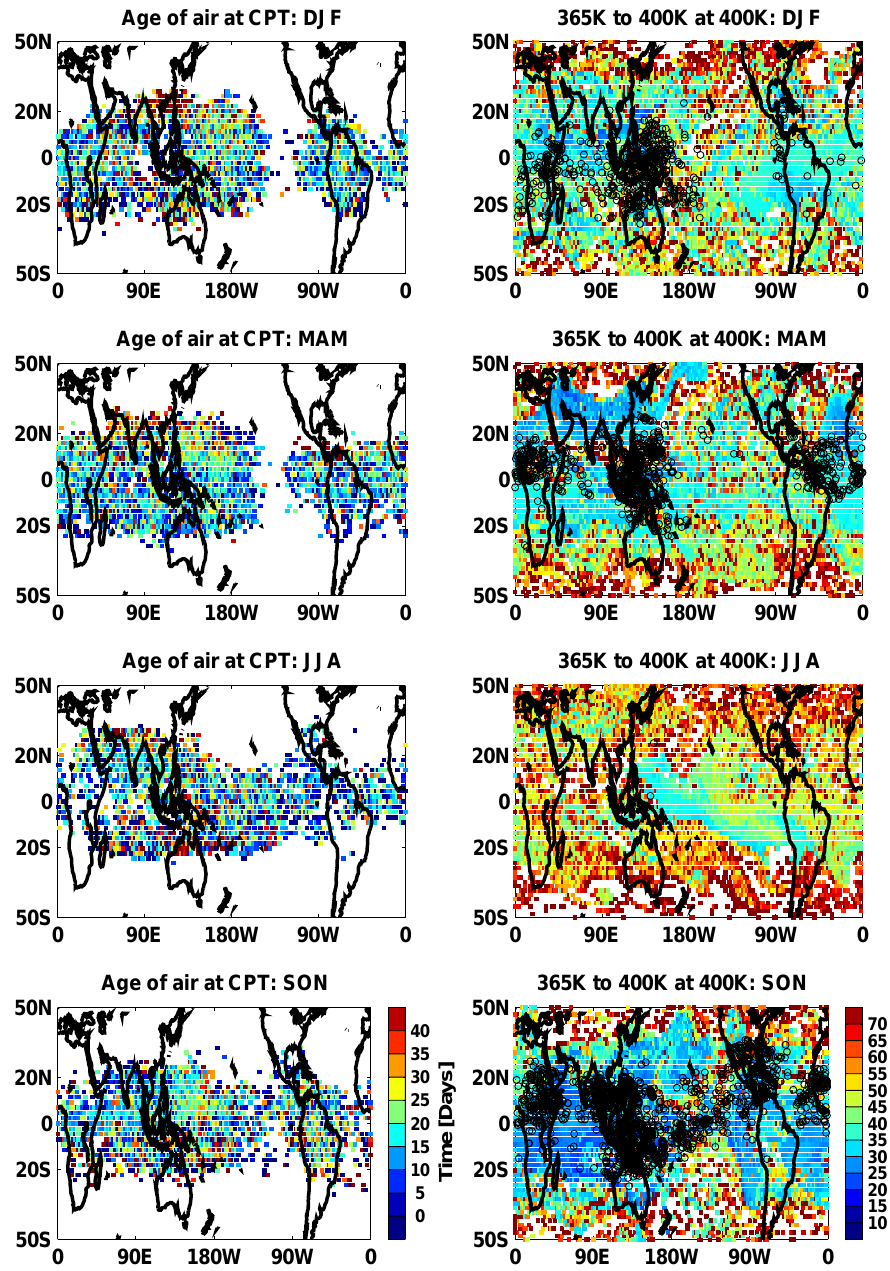
Fig. 6. Map of effective age of the air reaching the CPT at the CPT (left panels) for trajectories traversing the TTL in 2000 for all seasons. The right hand panels display the residence times from 365K to 400K at 400K. The black open circles in the right-hand panels display the trajectory locations at 355K if the residence times 365–400K are shorter than